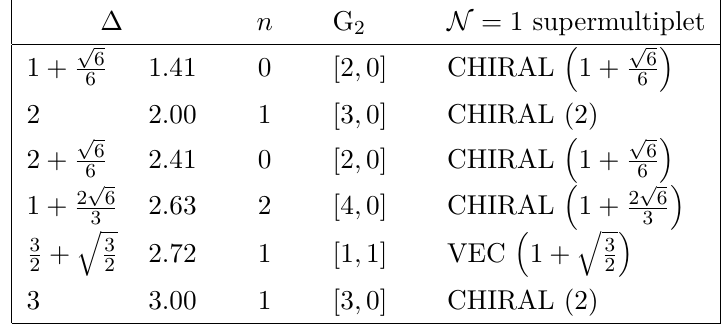
Table 11 . All KK scalars with dimension ∆ ≤ 3 around the N = 1 SU(3)-invariant AdS 4 solution of type